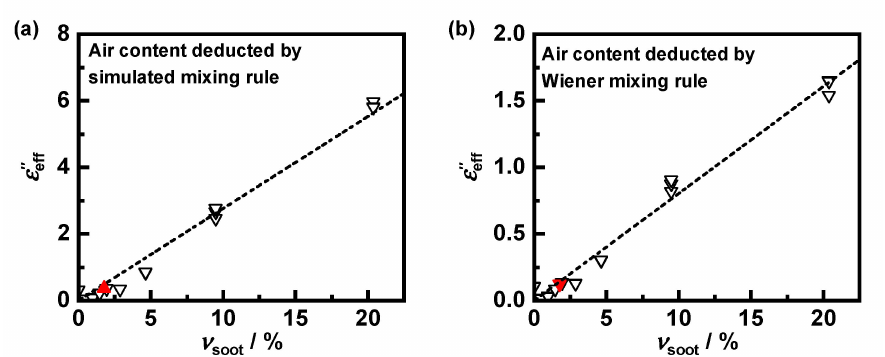
Figure 8. Effective dielectric losses of PrintexU–cordierite mixture ε (cid:48)(cid:48) depending on the volume eff fraction of PrintexU ν soot ; the influence of the air fraction was eliminated ( a ) by the mixing rule determined in Section 3.1 and ( b ), for comparison, by Wiener’s mixing rule. The data were measured with the smaller resonator (black triangles) as well as with the larger resonator under consideration of depolarization effects (red triangle); possible linear correlation (i.e., Wiener’s mixing rule) for mixtures between substrate and soot illustrated by the dotted regression